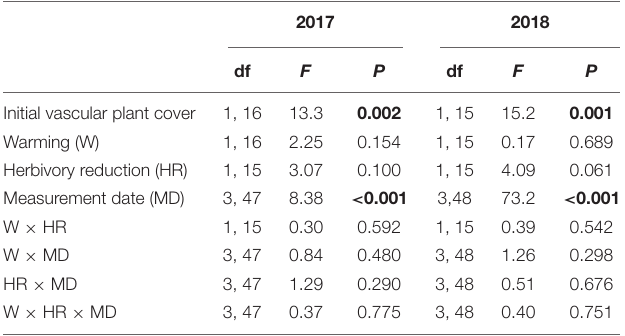
TABLE 6 | F and P statistics of the effects of warming (ambient, +3 ◦ C), herbivory reduction (normal, reduced) and initial vascular plant cover on soil respiration in field plots during 2017 and 2018 growing seasons (block was included in the model as a random factor, but is not reported; P < 0.05 are in